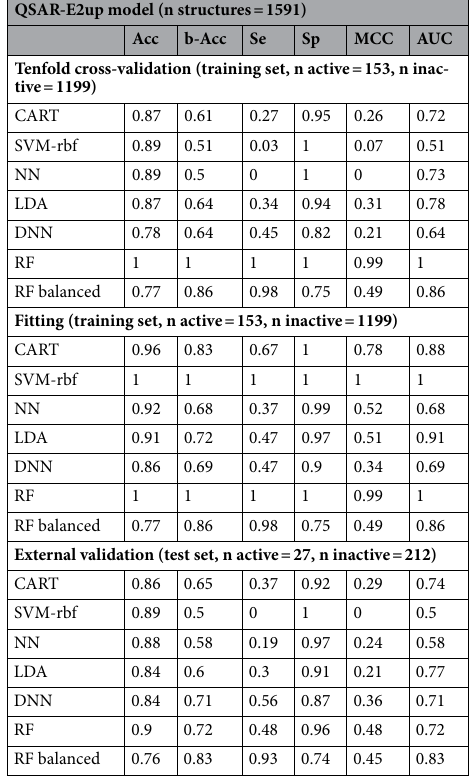
Table 2. Performance of QSAR classification models for E2up activity in H295R assay. Acc accuracy, b-Acc balanced accuracy, Sp specificity, Se sensitivity, AUC Area Under the Receiver Operating Characteristic Curve, MCC Matthew Coefficient Correlation, see “Material and